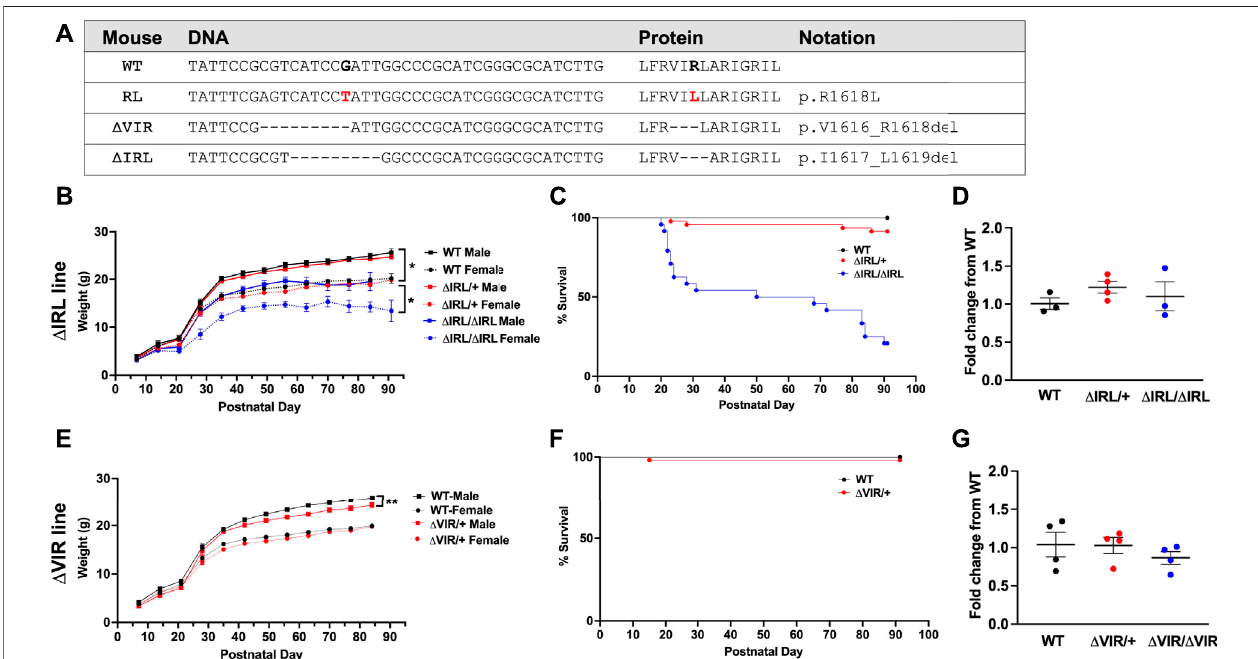
FIGURE2| Generationandcharacterizationofthe Δ IRLand Δ VIRmouselines. (A) DNAandprotein sequencealignment.WT,wild-typemousesequence, RL,the humanR1620L mutation (red) intheRL mouse line, Δ VIR, the3amino aciddeletion inthe Δ VIR mouse line, Δ IRL,the 3aminoaciddeletioninthe Δ IRLmouse line.Dash (-) indicates a deleted nucleotide or amino acid when compared to the WT sequence. (B) Homozygous Δ IRL/ Δ IRL mutants weigh signi fi cantly less than same-sex heterozygous Δ IRL/+mutantsandWTlittermates.Kruskal-WallistestfollowedbyDunn ’ smultiplecomparisons. (C) Approximately25%of Δ IRL/ Δ IRLmutantsand 90% of Δ IRL/+ mutants survive topostnatal day 90 (P90). Log-rank Mantel Cox test. (B and C) WT male N (cid:1) 10; WT female N (cid:1) 11; Δ IRL/+ male N (cid:1) 29; Δ IRL/+ female N (cid:1) 17, Δ IRL/ Δ IRLmale N (cid:1) 13; Δ IRL/ Δ IRLfemale N (cid:1) 11. (D) Scn8a mRNAexpressionlevelswerecomparableforthethreegenotypesinthe Δ IRLmouseline.Kruskal- Wallistest. N (cid:1) 3 – 4/genotype. (E) Heterozygous Δ VIR/+malemutantsweighsigni fi cantlylessthansame-sexWTlittermates.Female Δ VIR/+mutantsandWTlittermates had comparable weights. Paired Student ’ s t test. (F) Approximately 95% of Δ VIR/+ mutants survive to P90. Log-rank Mantel Cox test. (E and F) WT male N (cid:1) 27; WT female N (cid:1) 22; Δ VIR/+male N (cid:1) 18; Δ VIR/+female N (cid:1) 36. (G) Scn8a mRNAexpressionlevelswerecomparableforthethreegenotypesinthe Δ VIRmouseline.Kruskal- Wallis test. N (cid:1) 4/genotype. * p ≤ 0.05, ** p ≤